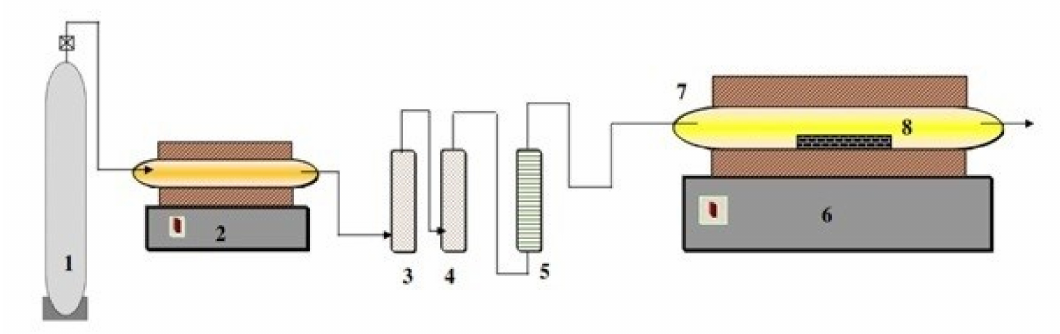
Figure 1. Schematic diagram for the experimental setup for vanadium carbide synthesize, 1—Argon gas cylinder; 2—Furnace containing copper turnings; 3—Pyrogallol; 4—Silica gel granules; 5—Flow meter; 6—Horizontal tube furnace (maximum temperature 1300 ◦ C); 7—Fused alumina tube;